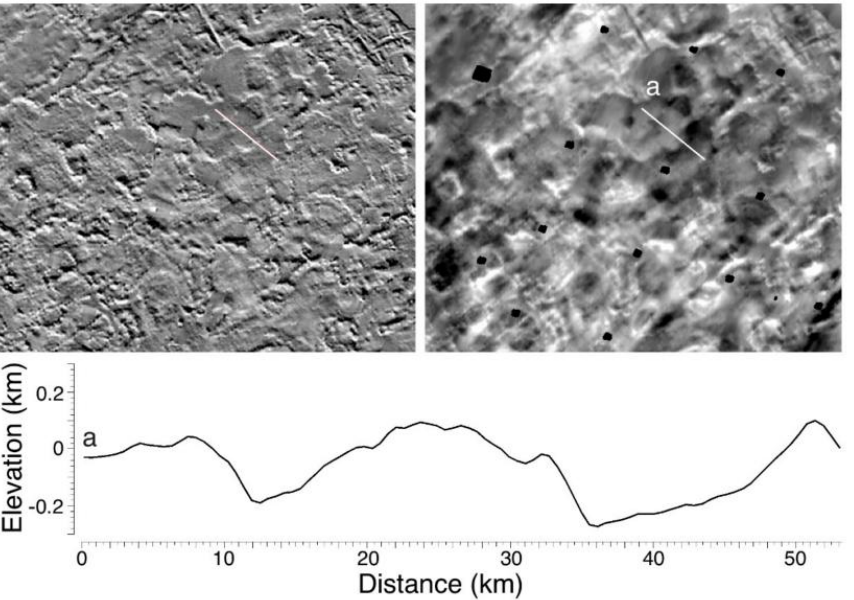
Figure 11. Topographic profile across scarp-bounded “layers” within cantaloupe terrain within cantaloupe terrain cavi, from SG-PC-DEM in Figure 8. ( top ) Image mosaic and ( right ) DEM scene width is ~260